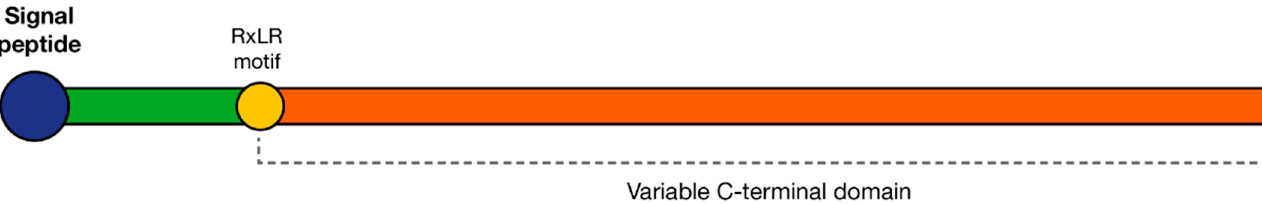
Figure 4. Phytophthora RxLR effector structure. Illustration of the characteristic features of Phytophthora RxLRs. These effectors have a signal peptide followed by a conserved RxLR (Arg-x-Leu-Arg) motif and a variable C-terminal.